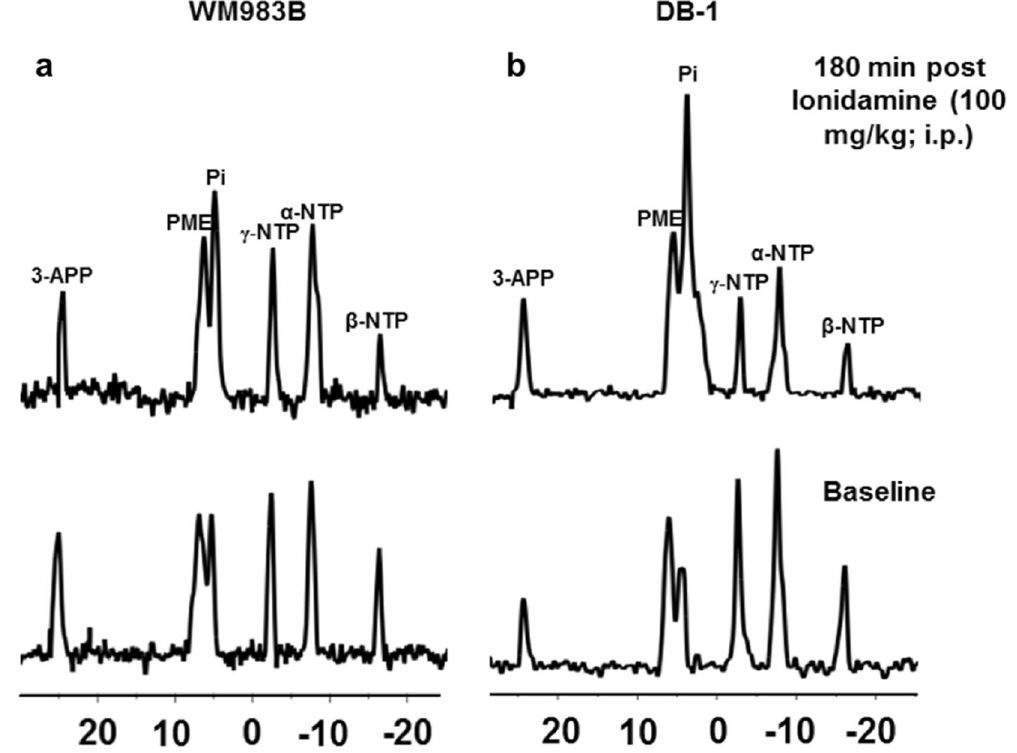
Figure 4. Lonidamine (LND) causes a decrease in bioenergetics in WM983B xenografts. We show representative in vivo localized (Image Selected In vivo Spectroscopy; ISIS) Phosphorus-31 magnetic resonance spectroscopy ( 31 P MRS) spectra of ( a ) WM983B and ( b ) DB-1 xenografts 43 . In each set, the lower spectrum represents the baseline and upper represents 180 minutes post-LND treatment. We mark resonances for 3-aminopropylphosphonate (3-APP), phosphomonoesters (PME), inorganic phosphate (Pi), γ -nucleoside- triphosphate ( γ -NTP), α -nucleoside-triphosphate ( α -NTP), and β -nucleoside-triphosphate ( β -NTP). A decrease in β -NTP levels with corresponding increase in Pi indicates impaired energy